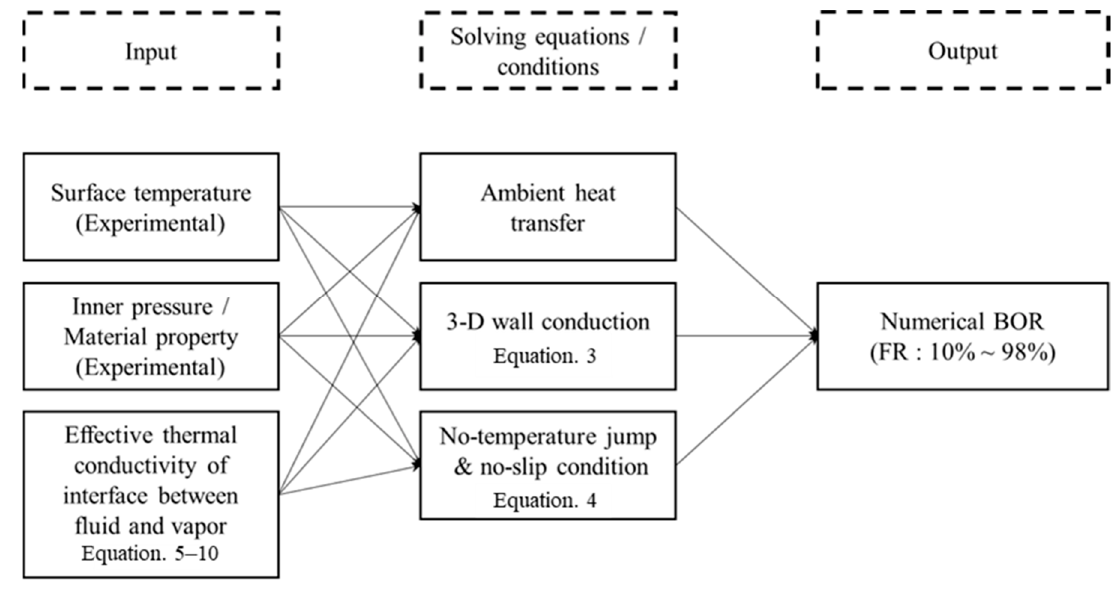
Figure 4. Flow chart depicting solution procedure.